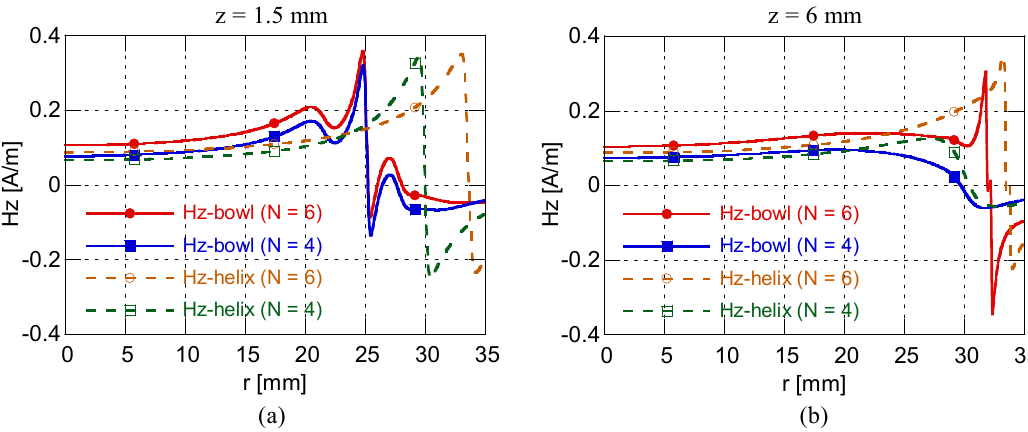
Figure 11. Calculated magnetic fields at ( a ) z = 1.5 mm and ( b ) z = 6 mm for the bowl-shaped Tx coil and helix coils of four- and six-turn coils.